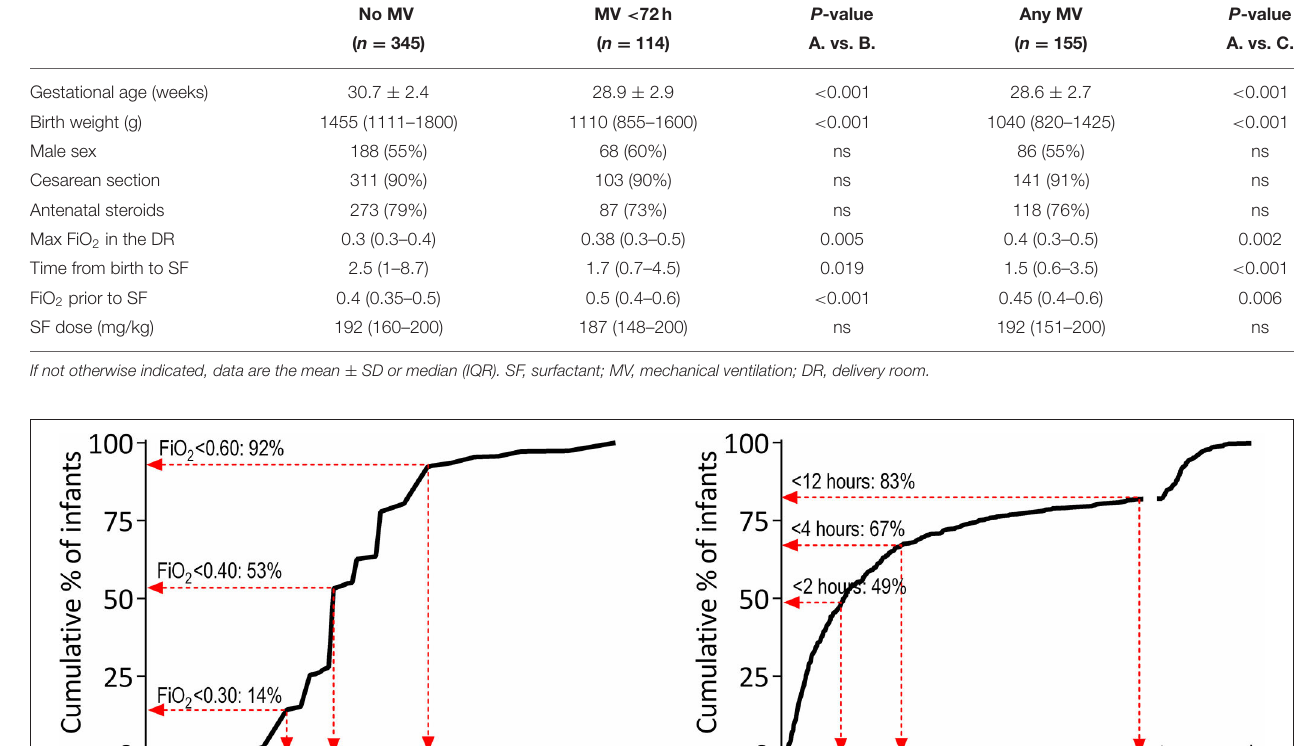
TABLE 1 | Baseline characteristics of the study cohort stratified by primary outcome. Time to SF